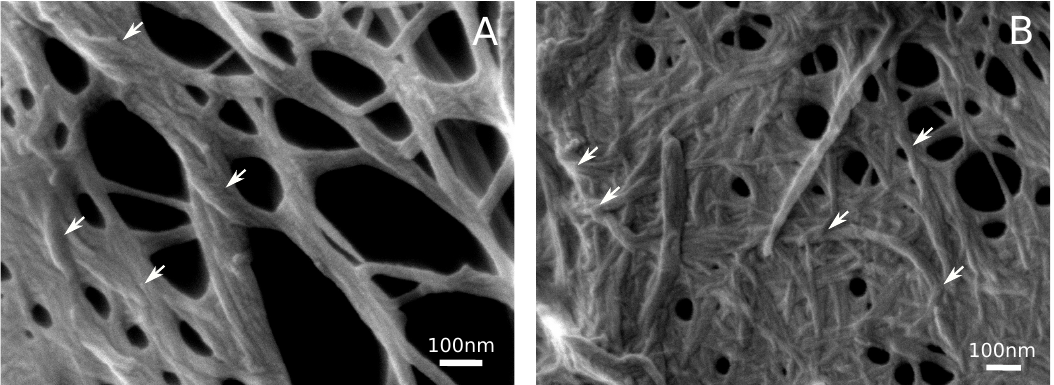
Figure 3. Typical SEM images of the lyophilized nanocellulose hydrogels (aerogels). Aerogel samples were rather heterogeneous, some areas were sparse ( A ), while others were dense ( B ). Arrows indicate helical and twisted zones of contact between